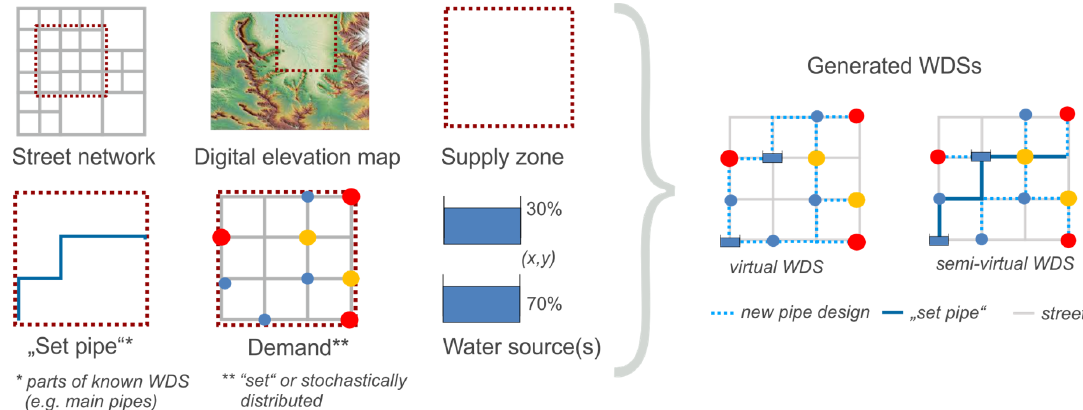
Figure 2. Concept of the stochastic generation of water distribution systems (WDSs). Following the idea from Sitzenfrei et al [22].